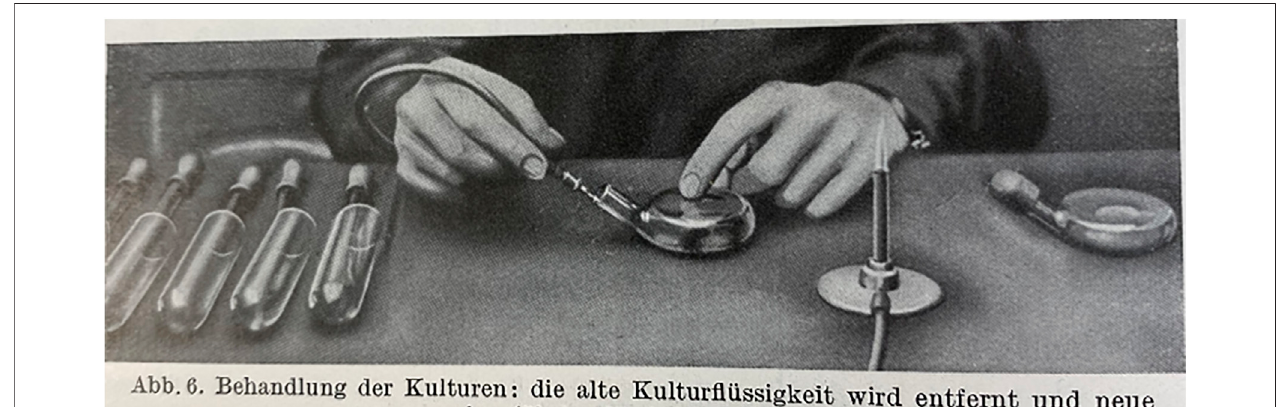
FIGURE 1 | Carrel fl asks as displayed in (Bis ̀ ceglie and Juhász-Schäffer 1928, 34).